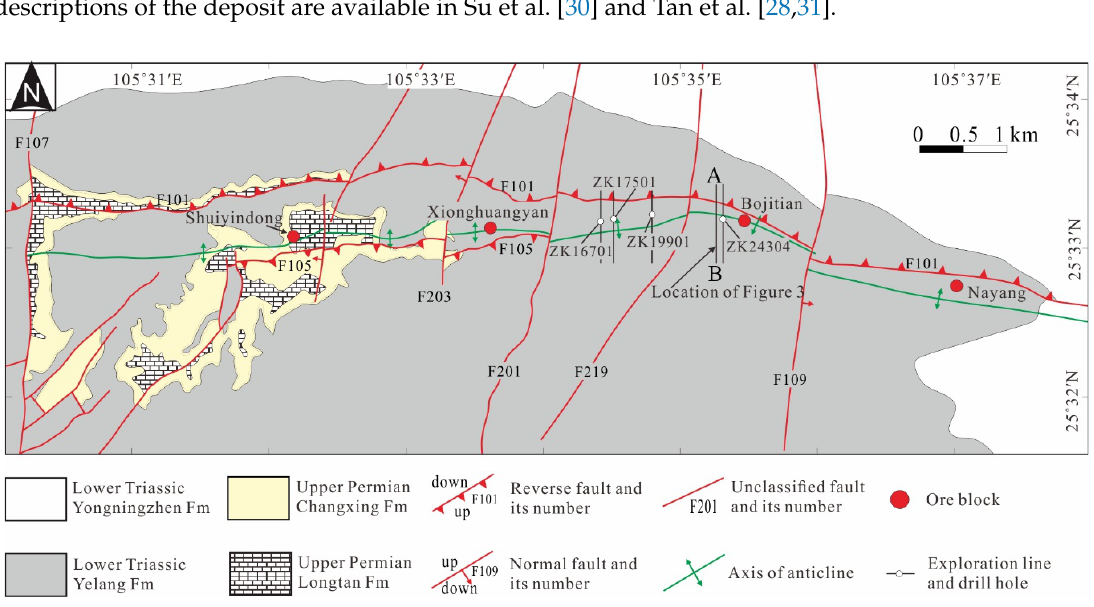
Figure 2. Geological map of the Shuiyindong gold deposit. The Shuiyindong mining area has been divided into four ore blocks: Shuiyindong, Xionghuangyan, Bojitian, and Nayang.